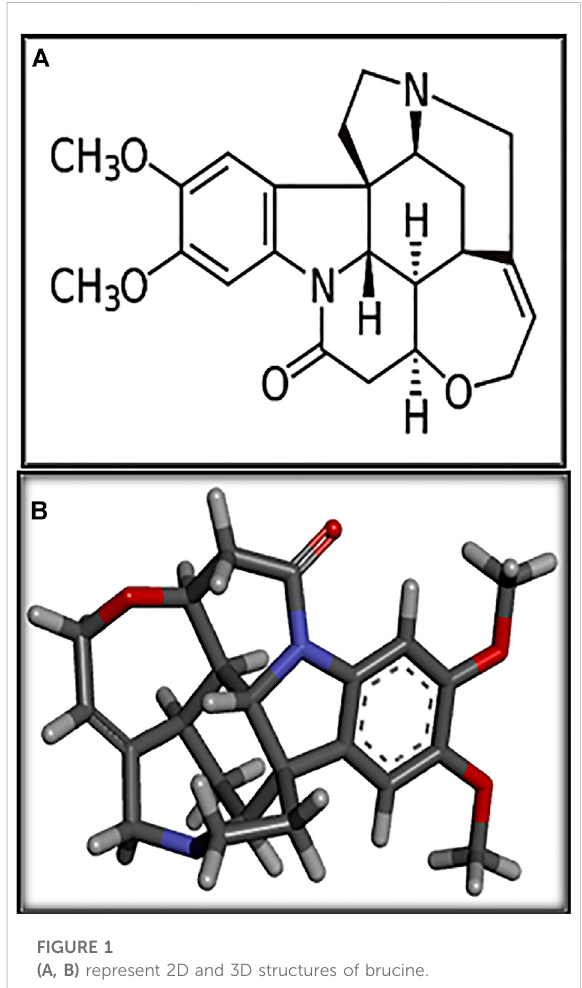
FIGURE 1 (A, B) represent 2D and 3D structures of